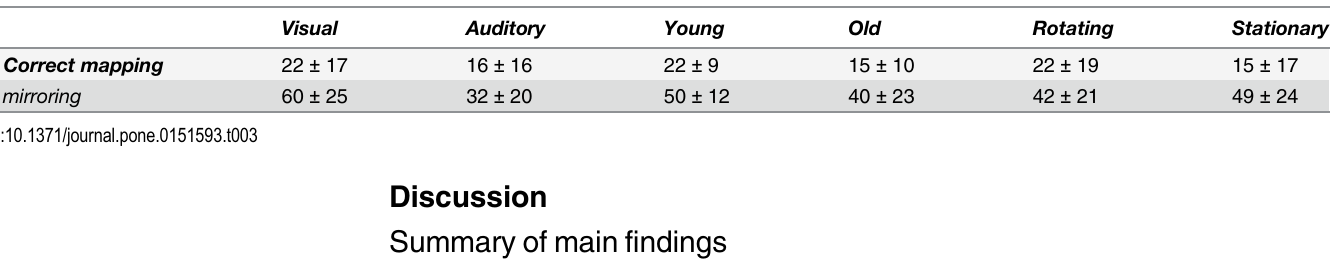
Table 3. Analysis of maze drawings. Values reported are means ±